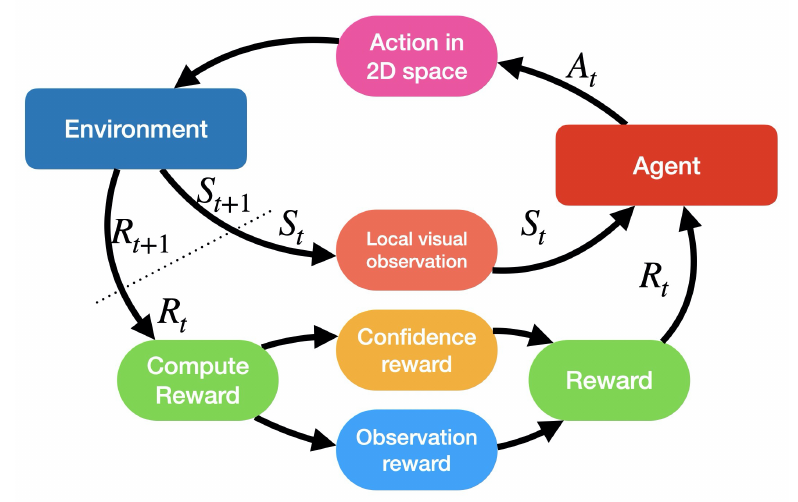
Figure 2. The workflow of our reinforcement learning (RL)